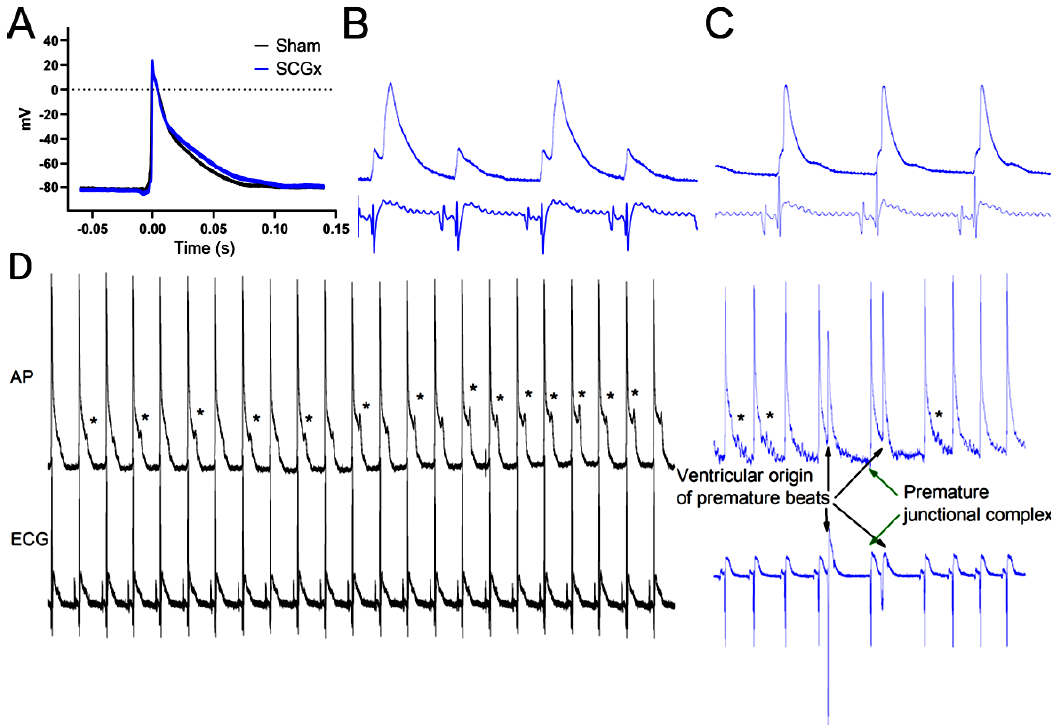
Figure 3. Epicardial action potential. ( A ) Averaged action potentials from preischemic recordings display a lengthening of 50% of repolarization in cardiomyocytes from SCGx hearts. ( B ) During ischemia, action potential (upper trace) activation delayed in respect of the beginning of the QRS complex of the ECG (lower trace). This is an indicator of reduced local propagation and suffered conduction blockage (2:1) causing repolarization alternants (blue traces correspond to 1 s). ( C ) Local activation delay persisted, and action potential shortened during the last minutes of ischemia, and early after-depolarization frequently occurred in SCGx group (blue traces correspond to 1 s). ( D ) During reperfusion, hearts from the sham group displayed early after-depolarizations (indicated by the asterisks), but they did not trigger arrhythmias as it can be seen in the ECG (black traces correspond to 6 s). In hearts from the SCGx group, early after depolarization triggered premature beats. Additionally, junctional complexes were also detected. The absence of P wave and QRS morphology like supraventricular activation (green arrows) are assumed to be an escape beat from the atrioventricular conduction system.